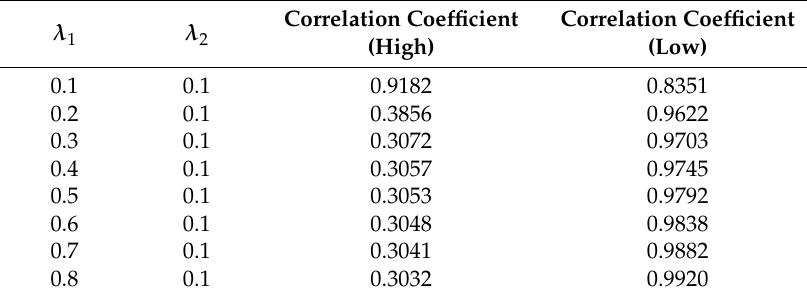
Table 3. Correlation coefficients in cases where λ 1 varies from 0.1 to